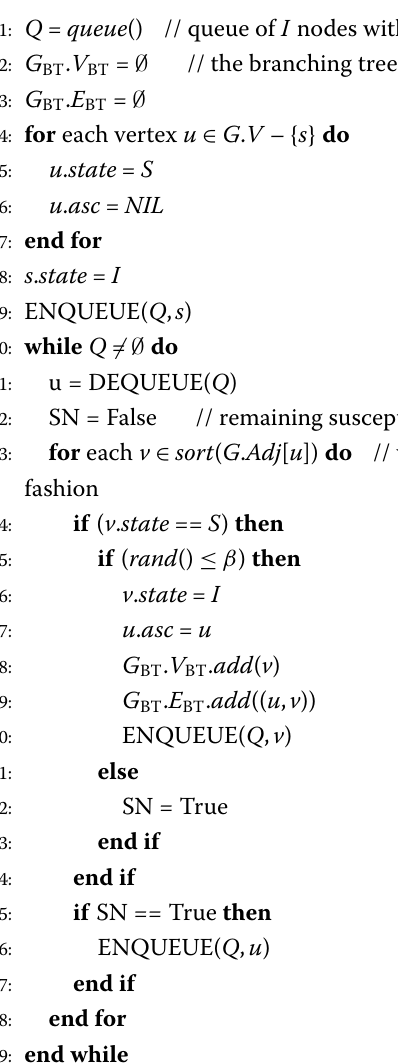
Algorithm 1: Susceptible-infected